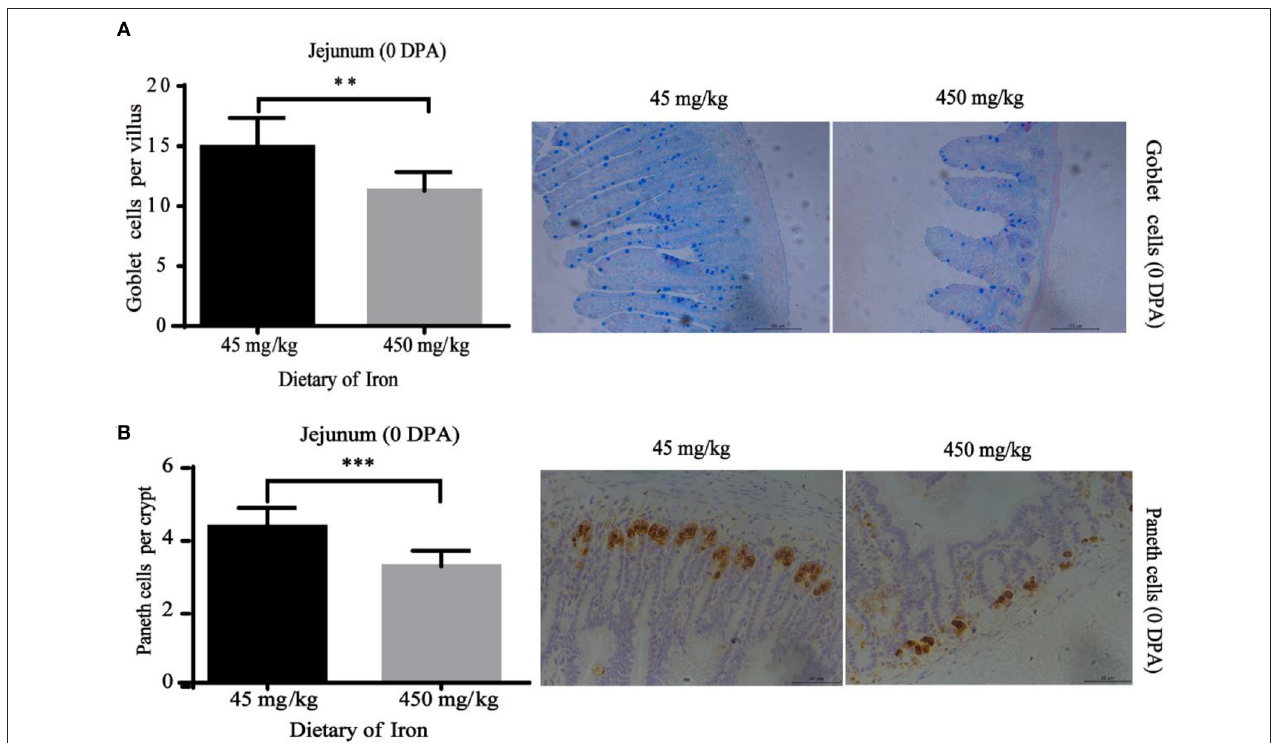
FIGURE 4 | Effects of dietary iron on intestinal epithelial cell renewal in adult mice at 0 DPA. (A) Goblet cell number of jejunum villi (B) Paneth cells number in jejunum crypt. n = 12. 0 DPA indicates “day 0 post administration,” which is day 21 of the whole experiment cycle. Note Scale bars. A used 100 µ m (magnification 200 × ), B